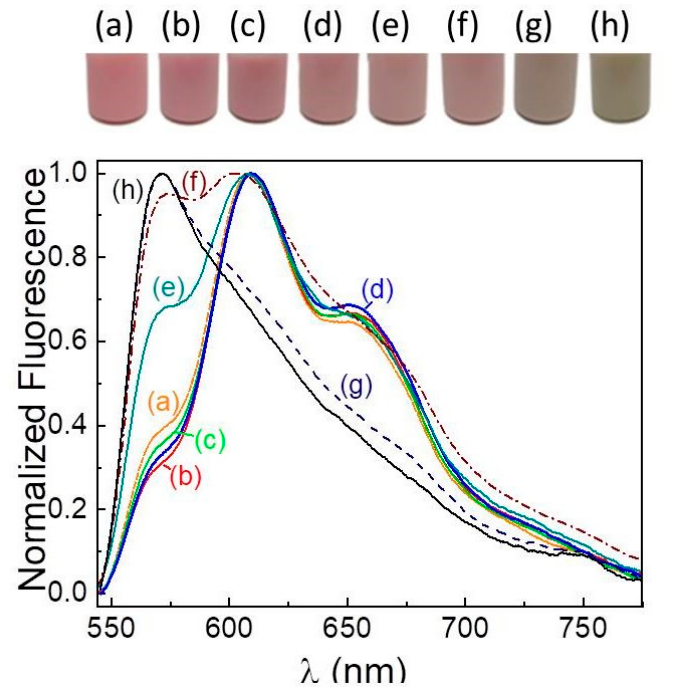
Figure 8. Fluorescence and photos of natural dye that was inserted in milk at different pH values: (a) 3.470, (b) 4.180, (c) 4.980, (d) 6.500, (e) 6.710, (f) 7.950, (g) 8.860, and (h) 10.430 ( λ = 532 nm, P e ≈ 50 mW, and L = 1 cm).